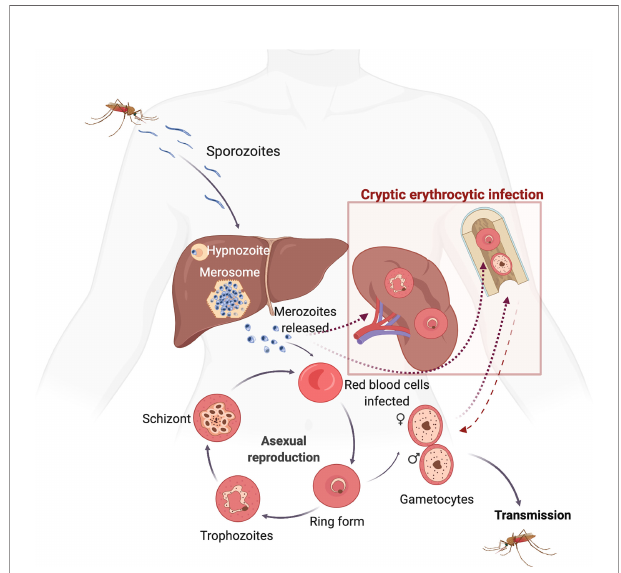
FIGURE 1 | Life cycle of Plasmodium vivax highlighting new cryptic erythrocytic stages. During a blood meal, malaria-infected mosquitos inject sporozoites which after reaching the bloodstream enter hepatocytes initiating the pre-erythrocytic cycle. Within the liver, P. vivax either differentiates (i) into a dormant stage called a hypnozoite which, upon reactivation, causes clinical relapses, or (ii) into tissue schizonts, which after thousands of mitotic replications in membranous sacks known as merosomes, release merozoites into the bloodstream initiating the erythrocytic cycle. In this cycle, P. vivax merozoites predominantly, if not exclusively, invade reticulocytes starting asexual blood stage differentiation of rings, trophozoites, schizonts and egress to invade new red blood cells. This cyclical developmental process takes about 48 h. In addition, P. vivax produces speci fi c proteins to create caveola – vesicle complexes that appear as profuse speckling in Giemsa-stained blood smears, known as Schüfnner ’ s dots. Moreover, some P. vivax parasites can differentiate into mature gametocytes before a clinical infection and illness develops, thus having the advantage of continued transmission to the insect vector before the appearance of clinical symptoms and subsequent treatment. Remarkably, presence of parasites in the spleen and the bone marrow represents novel cryptic erythrocytic infections that need to be incorporated in the life cycle of this species (boxed). Infections of these organs can be either directly from invasion of merozoites into the reticulocyte-rich bone marrow and spleen, or by infected- reticulocytes in peripheral blood. Circulating gametocytes are rounded shape and on uptake in the blood meal of anopheles mosquitoes begin the sexual cycle. This includes release of the male and female gametes, fertilisation, and formation of a motile ookinete that crosses the midgut epithelium. Differentiation into a new replicative form known as the oocyst, release of sporozoites, migration, and invasion of the salivary glands ends this complex life cycle in which the parasite undergoes more than ten stages of cellular differentiation and invades at least four types of cells within two different hosts. (Created with BioRender.com by Carmen